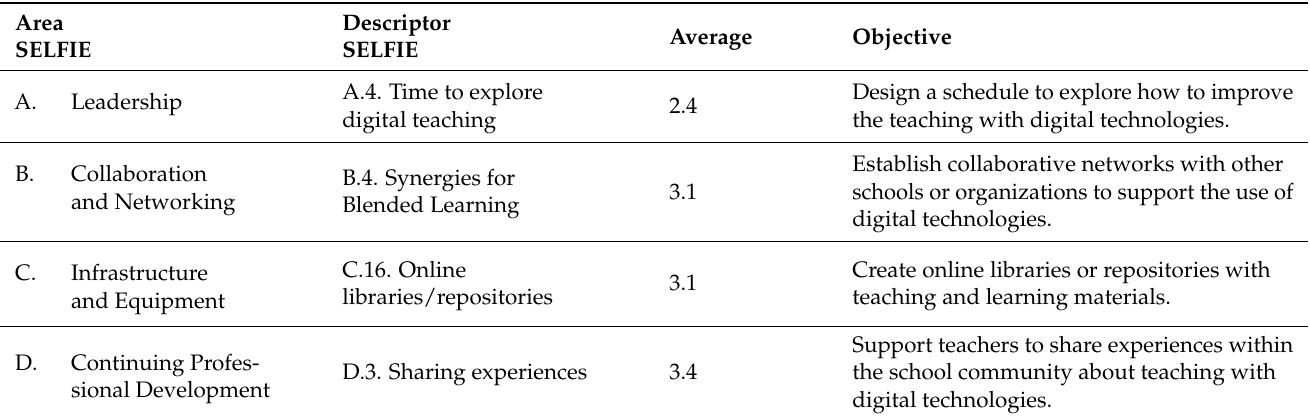
Table 11. 2021–2022 digital improvement goals for each SELFIE